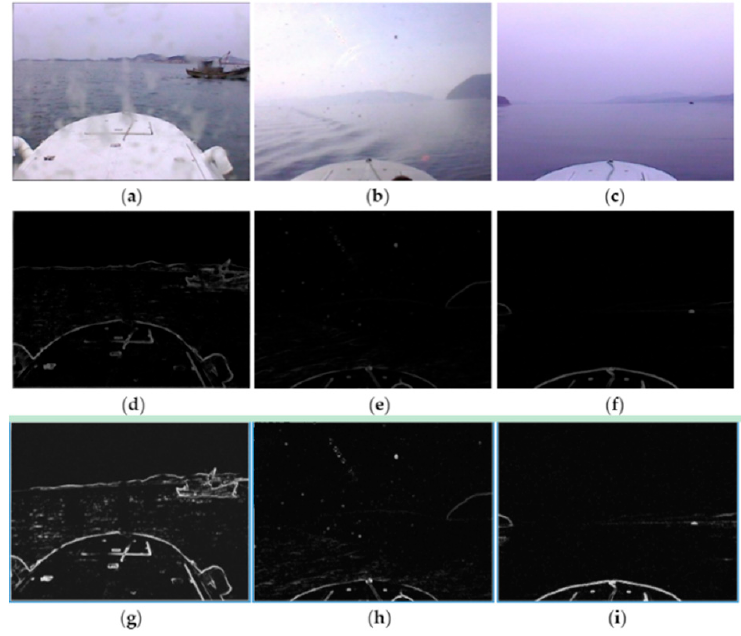
Figure 3. Gradient maps and gradient saliency maps of optical images in typical adverse weather conditions. ( a – c ) are original images; ( d – f ) are gradient maps; ( g – i ) are gradient saliency maps.